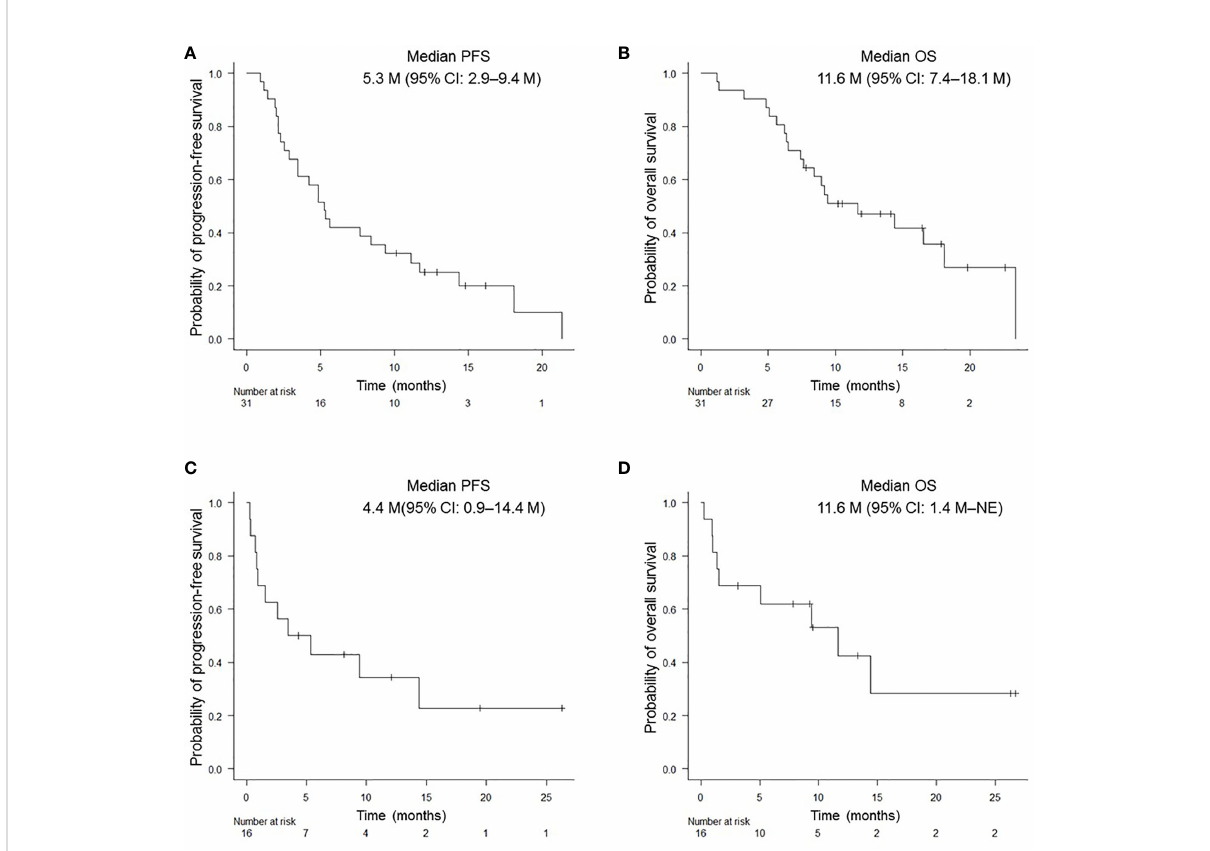
FIGURE 1 Kaplan-Meier survival curves for PFS and OS in NSCLC patients. PFS (A) and OS (B) of patients aged ≥ 75 years who received pembrolizumab monotherapy. PFS (C) and OS (D) of patients with PS of 2. PFS, progression-free survival; OS, overall